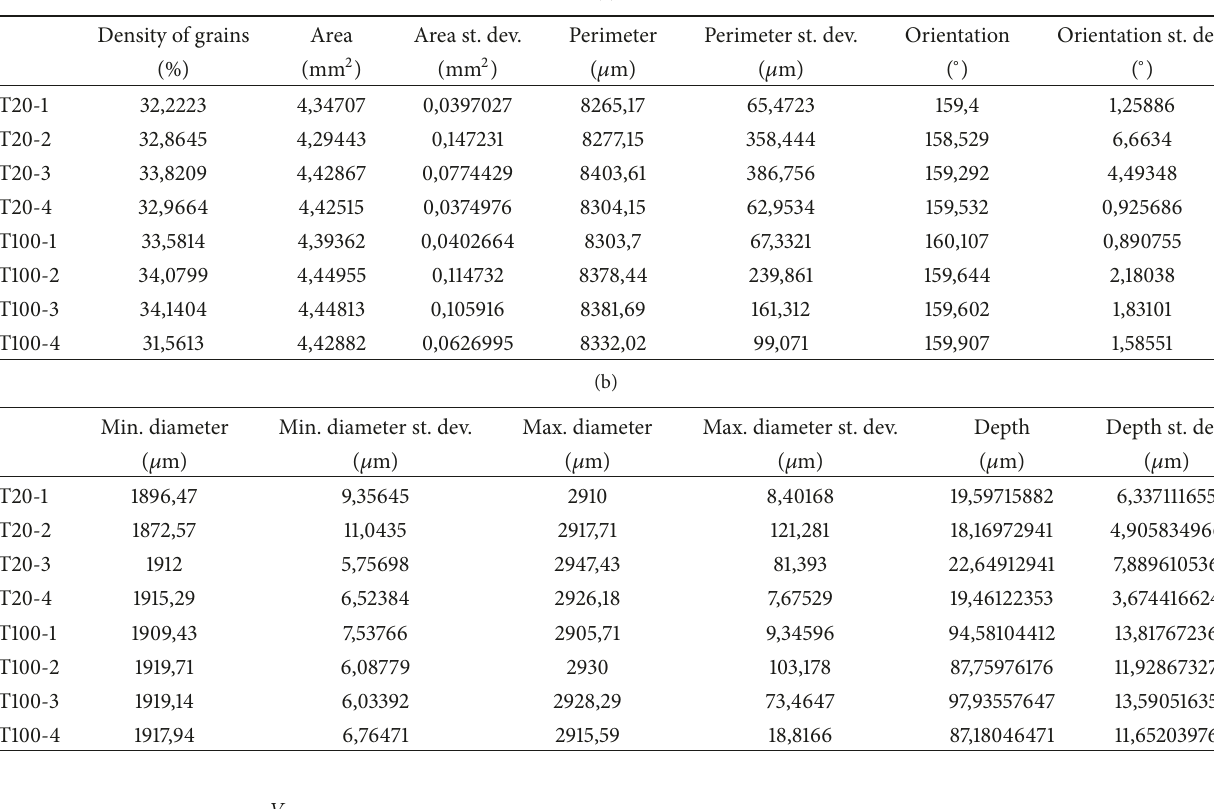
Table 4: The table shows a complete overview of the measured dimensions of the textured samples.